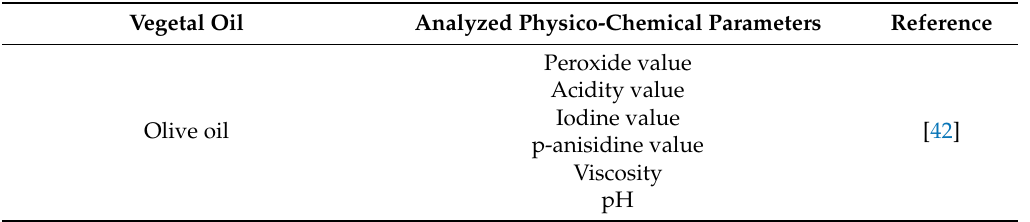
Table 1. Chemical and physical parameters of ozonated